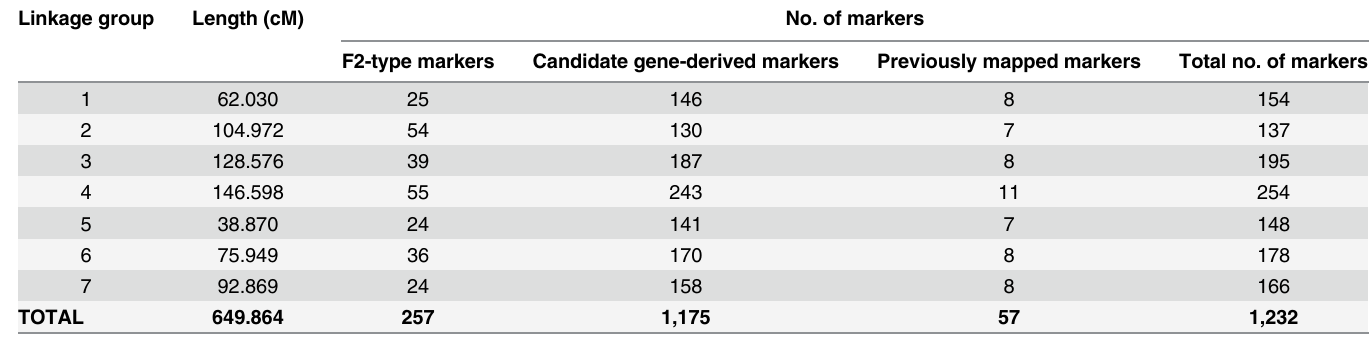
Table 1. Details of the SNP-based linkage map. The F2-type map was built using only the SNPs which showed F2 type segregation. The final map includes all available SNPs, along with 57 previously mapped markers